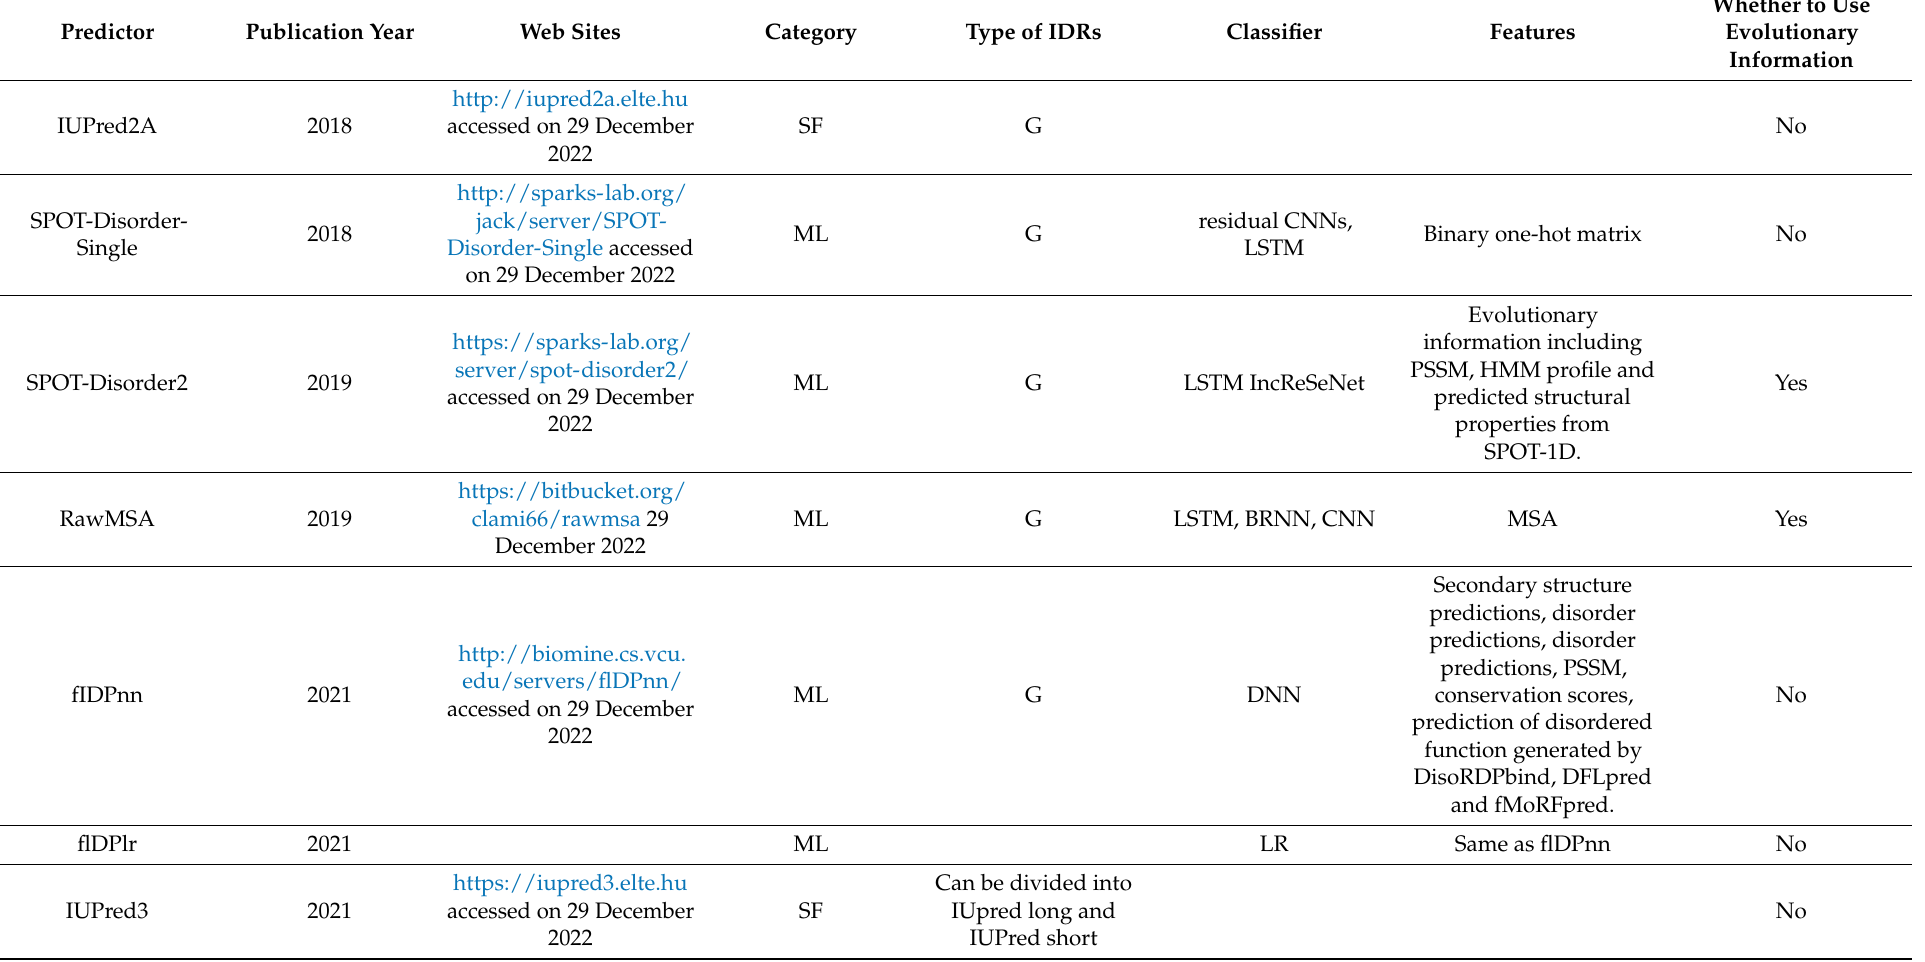
Table 2. The summary of IDP/IDR